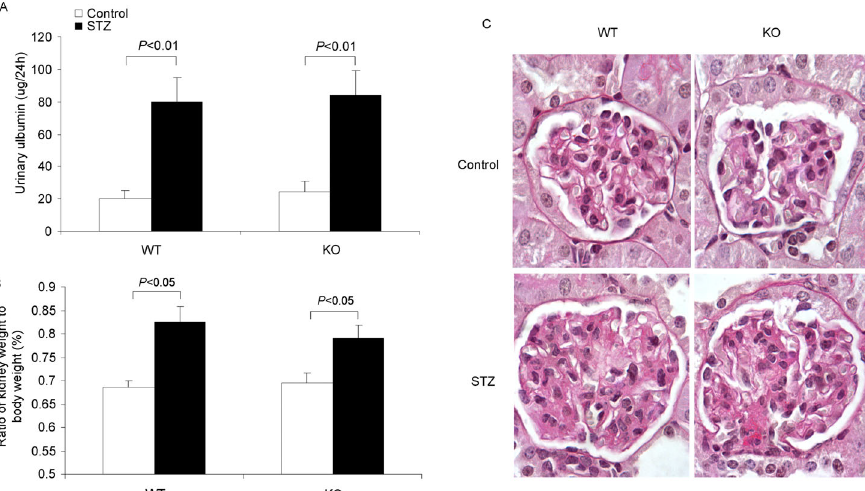
Figure 2. Evaluation of the diabetic kidney injury in mPGES-1 WT and KO mice. (A) The urinary albumin excretion after 6 weeks of diabetes. (B) Ratio of the kidney weight to the body weight (%). (C) PAS staining of the glomeruli after 6 weeks of diabetes. N=6–9 in each group. Data are mean 6 SE.